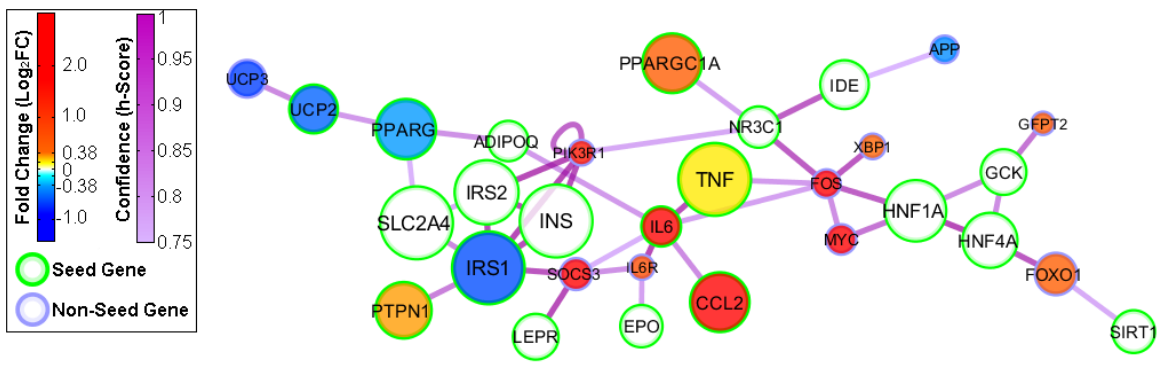
Figure 2: Top-20 significant genes in IAB from GSE24215, interacted with T2D-associated genes. Node size represents Evidence for each gene, node color represents Log2_FC, red color implies over-expressed and blue color implies under-expressed. Green circled nodes are seed genes (T2D-associated genes curated from OMIM). Edge color represents Confidence (h-Score) for each